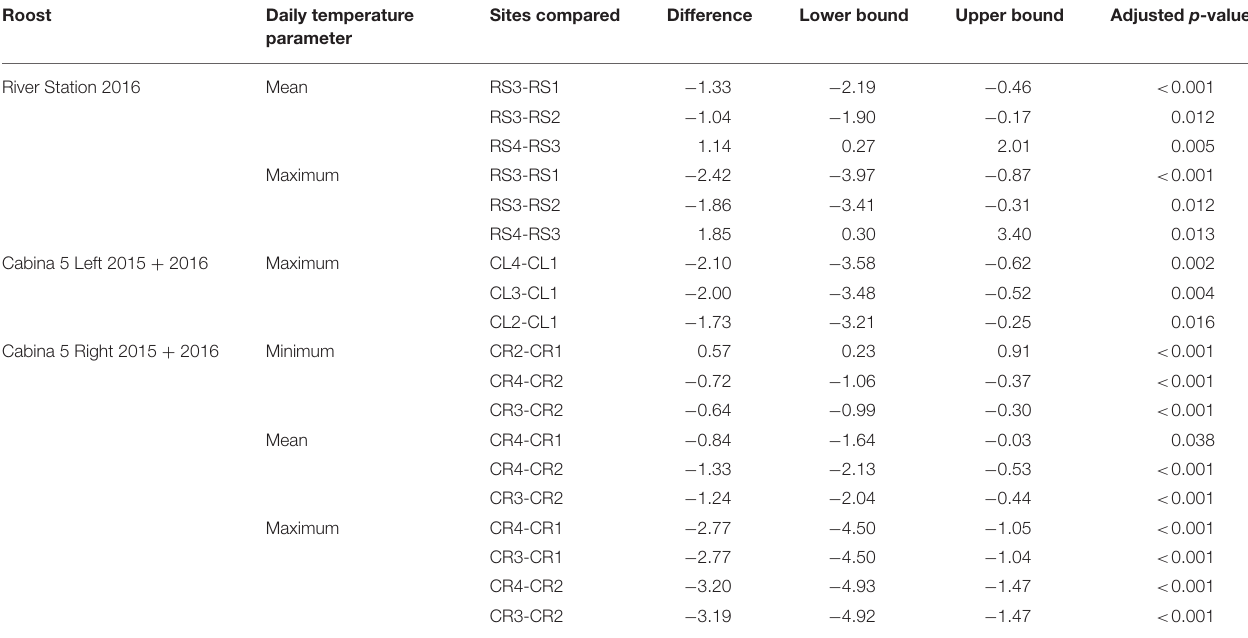
TABLE 4 | Results of post-hoc comparisons using Tukey-HSD test to compare temperature parameters between individual roost sites. Roost Daily temperature Sites compared Difference Lower bound Upper bound Adjusted p -value parameter River Station 2016 Mean RS3-RS1 − 1.33 − 2.19 − 0.46 < 0.001 RS3-RS2 − 1.04 − 1.90 − 0.17 0.012 RS4-RS3 Maximum RS3-RS1